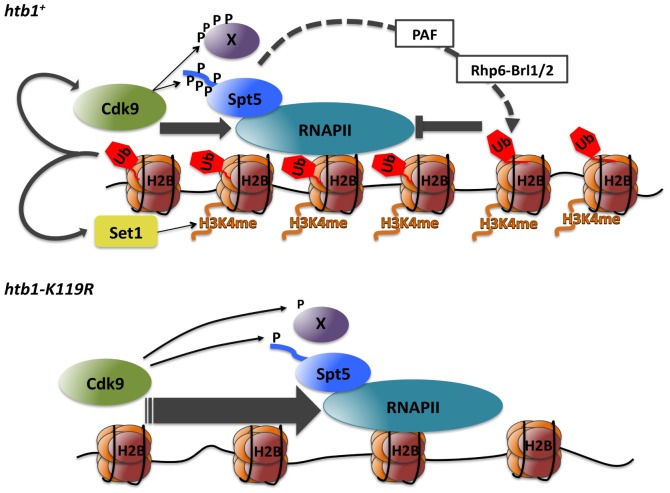
Model depicting positive and negative interactions between P-TEFb and H2Bub1 during transcript elongation (see text for details).